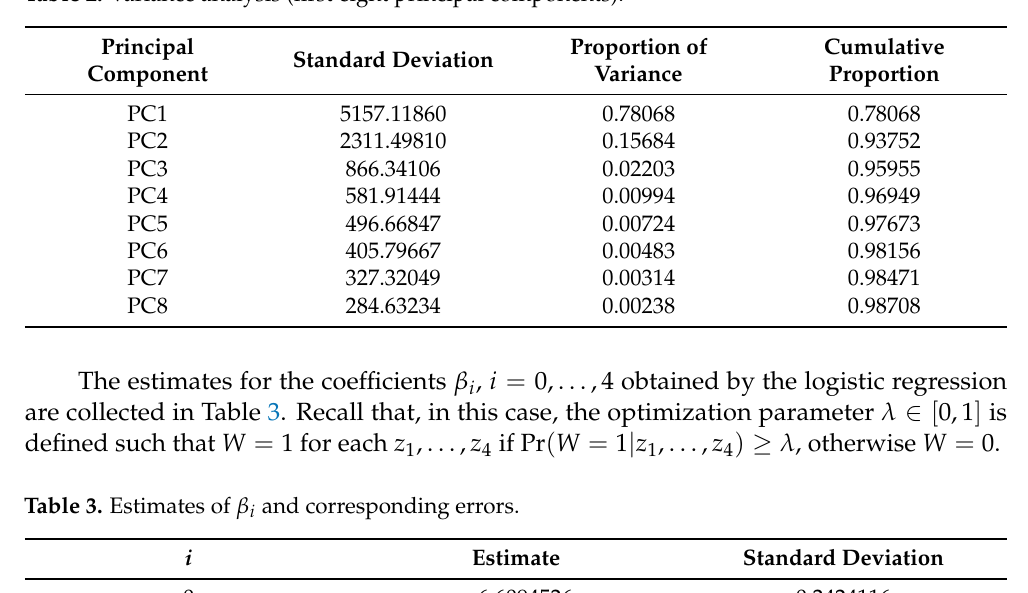
Table 2. Variance analysis (first eight principal components).